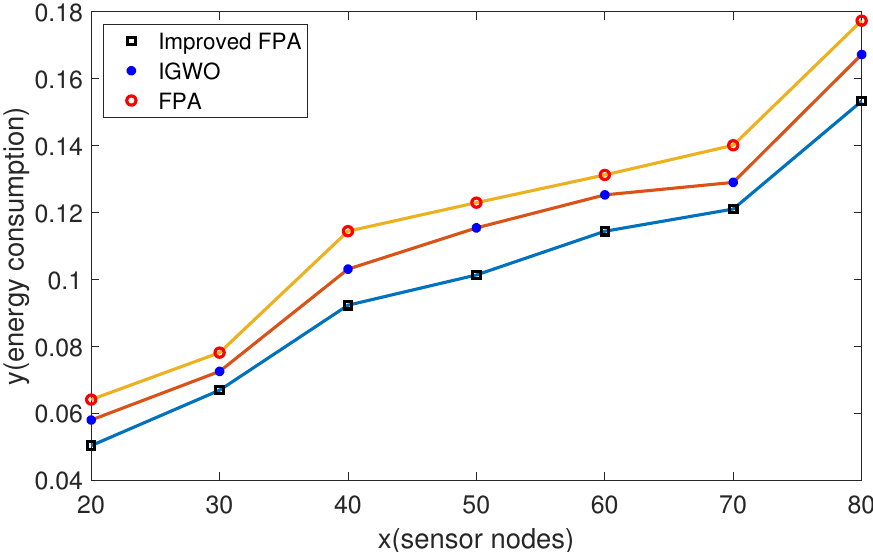
Figure 7. Energy consumption of the three algorithms under different number of